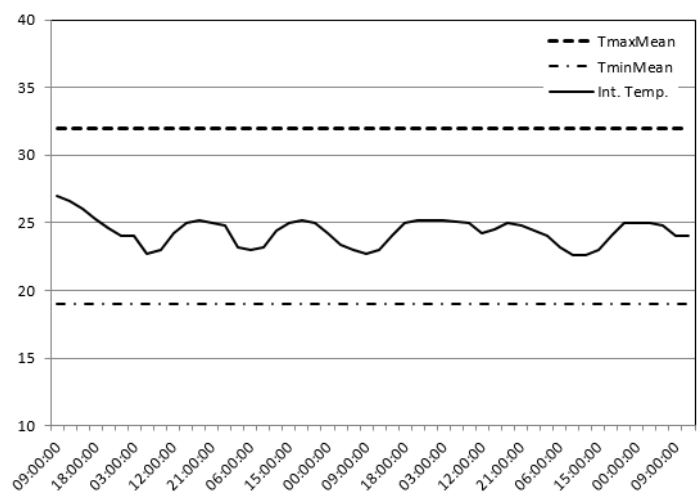
Figure 11. Air temperatures recorded inside a traditional courtyard